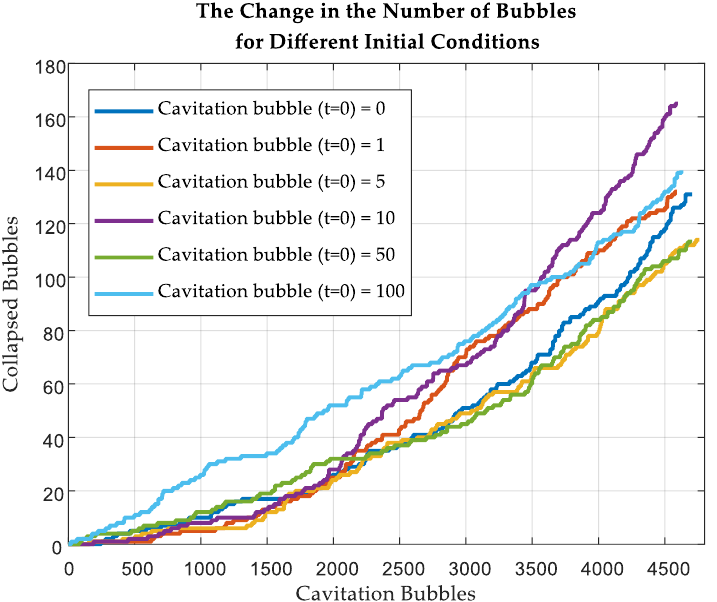
Figure 9. Simulation 4: Cavitation and collapsed bubbles with changes in the initial conditions.